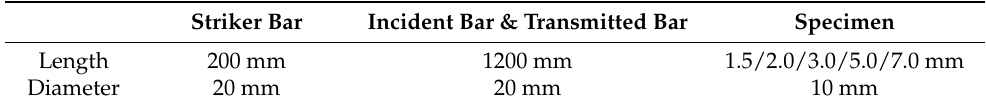
Table 3. The dimensions of each part in FEM modeling.